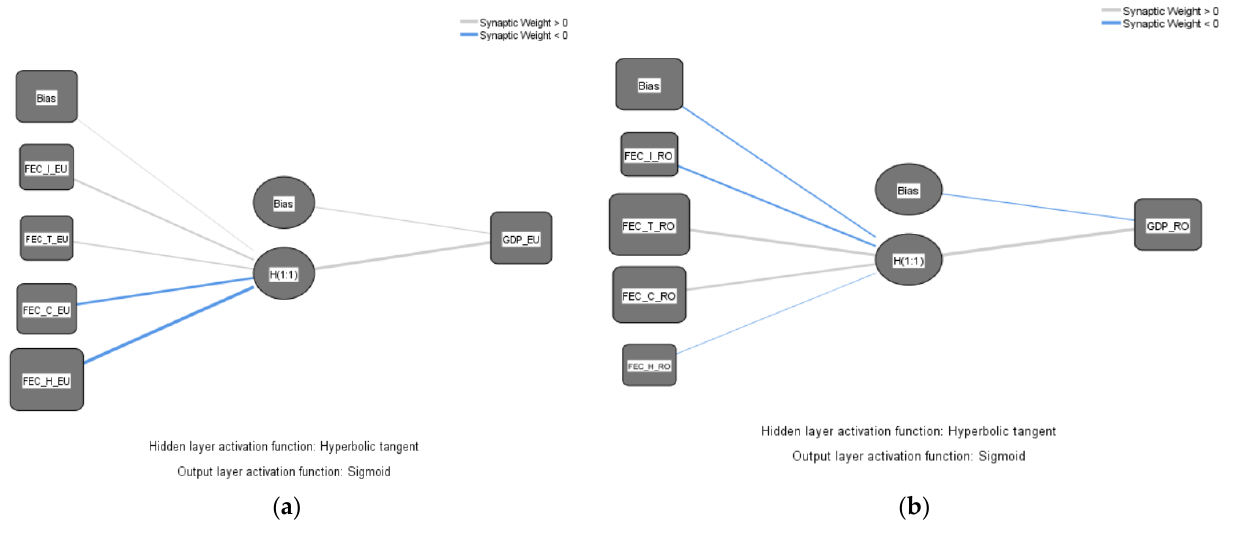
Figure 17. MLP network to identify the sector-specific influences of final renewable energy consumption on economic growth: ( a ) EU; ( b ) RO.